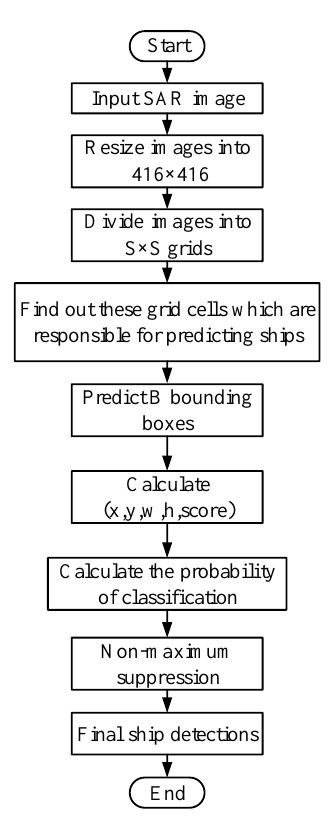
Figure 7. G-CNN ship detection model. (a) Original image; (b) S × S grids; (c) find out these grid cells which are responsible for predicting ships; (d) bounding boxes + score; (e) class probability map; (f) final detections.